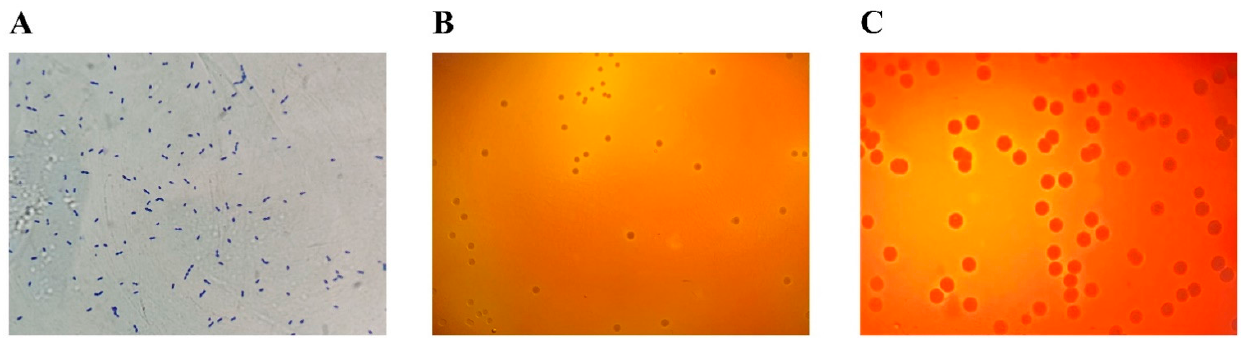
Figure 1. Morphology of Blautia producta DSM 2950. ( A ) Gram stain morphology of DSM 2950. ( B ) Hemolytic properties of DSM 2950. ( C ) Hemolytic properties of Staphylococcus aureus .